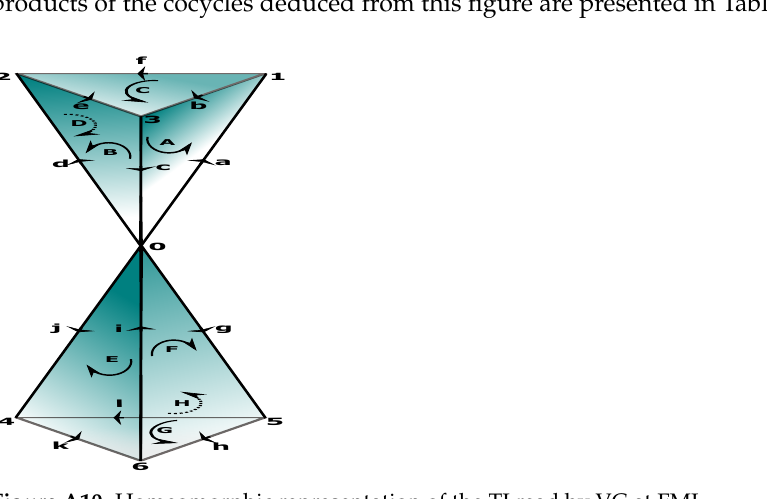
Figure A10. Homeomorphic representation of the TI read by VC at